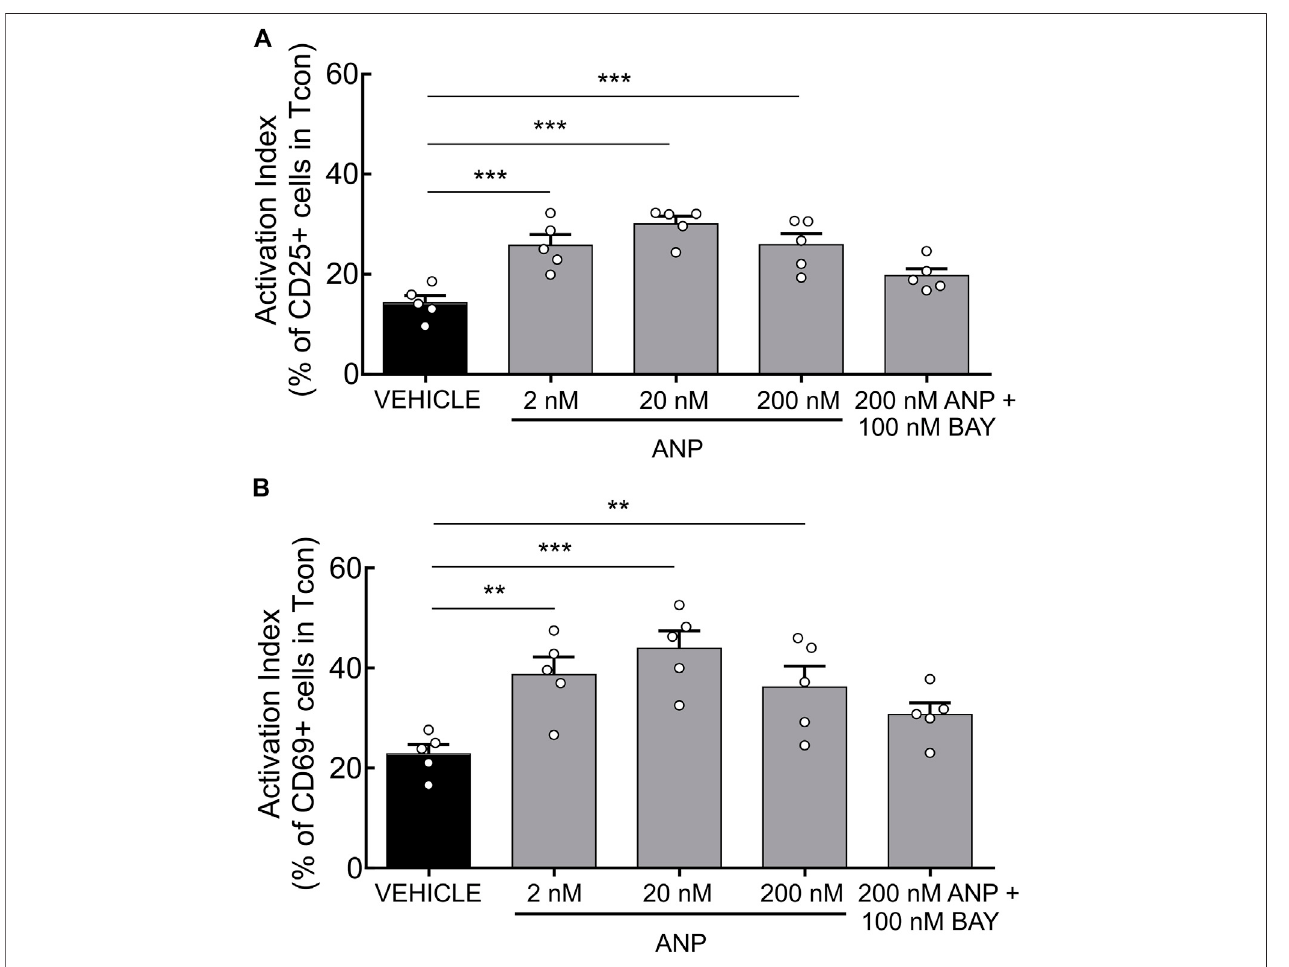
FIGURE 4 | ANP stimulation enhances T cell activation in CD4 + T cells. MACS-puri fi ed Tcon were stimulated for 6 h in presence of anti-CD3/CD28 and ANP. Surface expression of CD25 and CD69 was assessed by fl ow cytometry. Results are presented as an activation index calculated as the difference of (A) CD25 and (B) CD69 expression between anti-CD3/CD28 stimulated and unstimulated CD4 + T cells . Bar graphs show quanti fi ed values of fi ve individual animals per group. The signi fi cance of data was con fi rmed by repeated-measures one-way ANOVA followed by Dunett ’ s multiple comparison test; ** p < 0.01, *** p < 0.001.